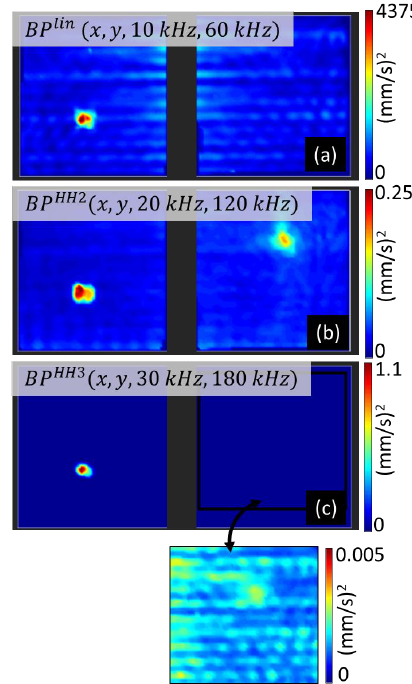
Figure 6. Band power maps calculated using Equation (6) for ( a ) linear velocity component, ( b ) second harmonic component and ( c ) third harmonic component. harmonic component and ( c ) third harmonic